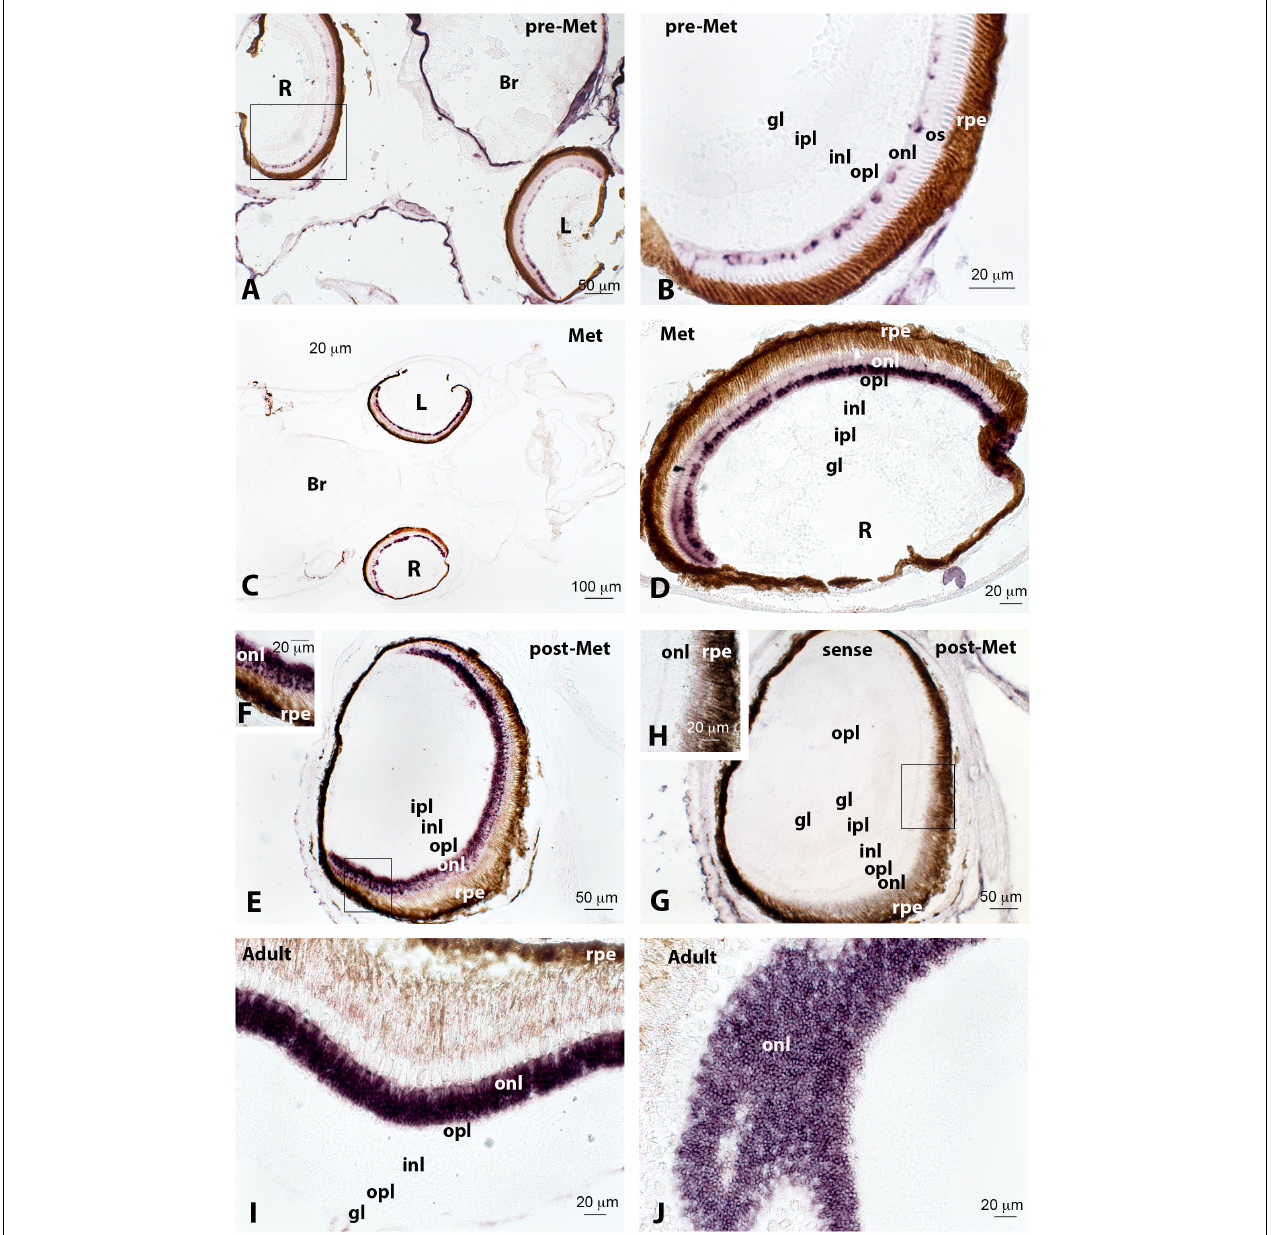
FIGURE 2 | Localisation of rod opsin ( rh1 ) expression in the retina of pre-metamorphic (pre-Met; A,B ), metamorphic (Met; C,D ), post-metamorphic (post-Met; E–H ), and adult (I,J) Senegalese sole specimens revealed by in situ hybridisation. All the photomicrographs represent antisense sections, with the exception of panels (G,H) , which show sense control sections. The photomicrograph represented in panel (J) shows a tangential section through the outer nuclear layer (onl), exhibiting abundant positive rh1 -expressing cells. Squares in panels (A,E,G) mark the areas magnified in photomicrographs (B,F,H) , respectively. Note how the expression of rh1 in rods of onl increases markedly in the post-metamorphic and adult retina compared to the previous stages. Other abbreviations: Br, brain; gl, glomerular layer; inl, internal nuclear layer; ipl, internal plexiform layer; L, left retina; opl, outer plexiform layer; os, outer segment of photoreceptors; R, right retina; rpe, retinal pigment epithelium. Scale bars represent 20 µ m in panels (B,D,F,H,I,J) ; 50 µ m in panels (A,E,G) ; and 100 µ m in panel (C)